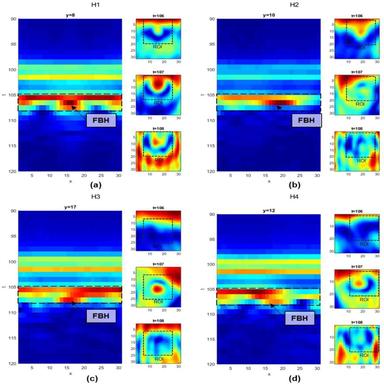
Tomography representing the location of FBHs: (a) H1, (b) H2, (c) H3 and (d) H4.